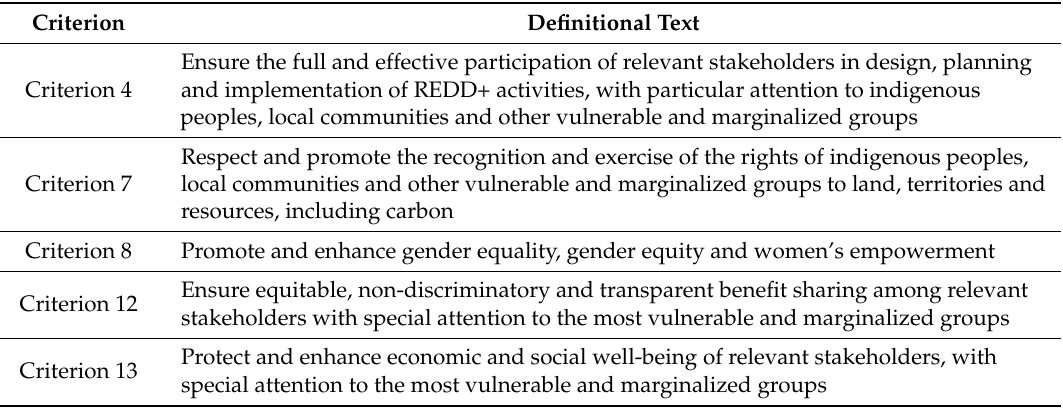
Table 2. Criteria relating to social equity established by the UN-REDD program on Social and Environmental Principles